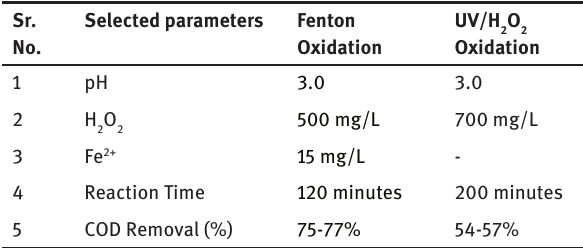
Table 1: optimum condition for Fenton and UV/H mineralization of selected UV absorbers